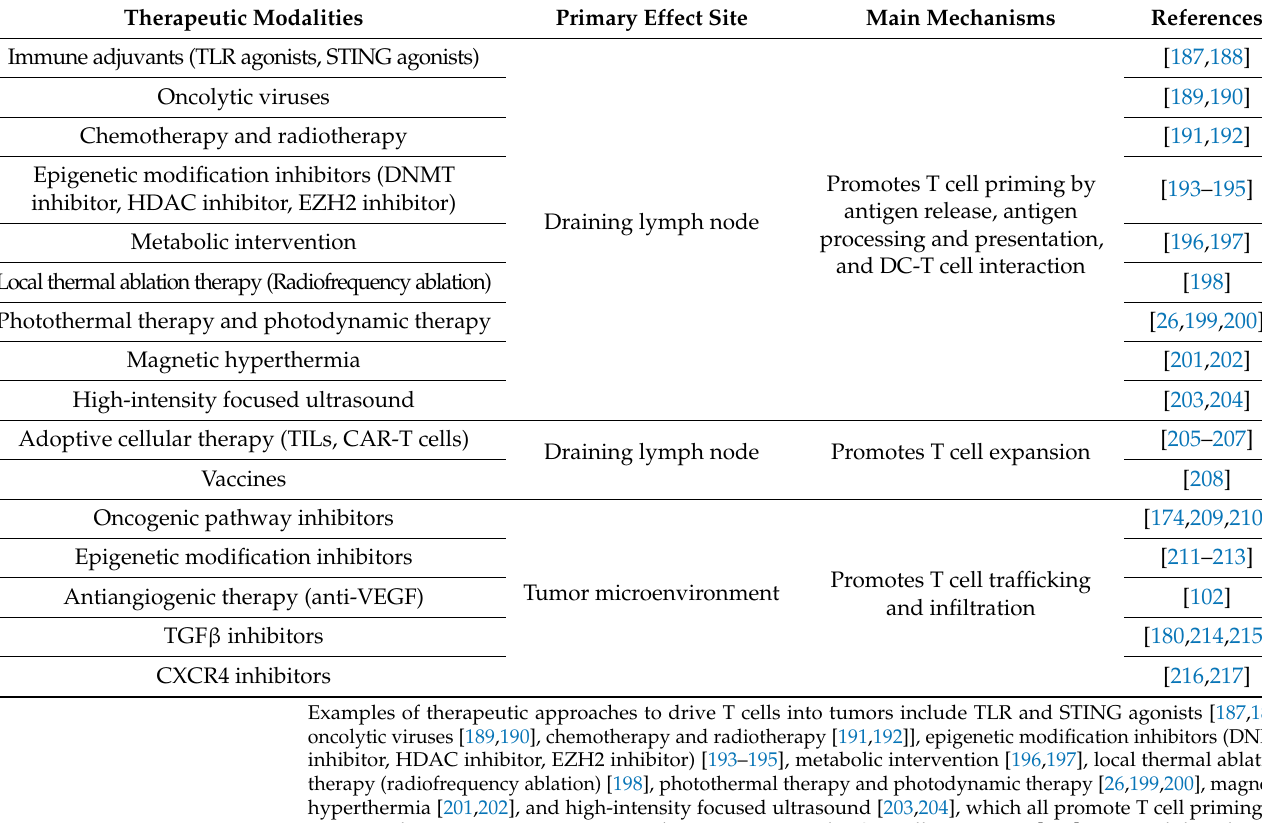
Table 4. Therapeutic strategies to turn “cold tumors” into “hot tumors”.